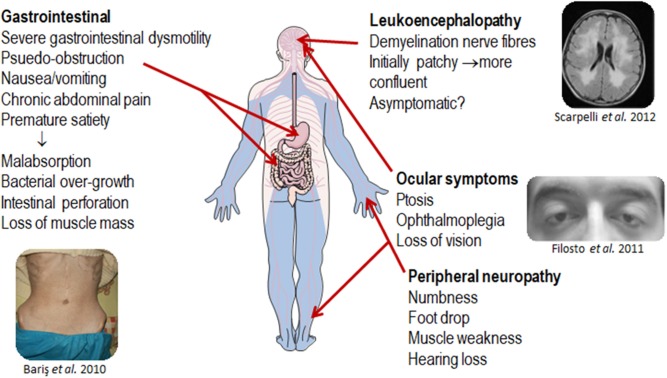
Major clinical features of MNGIE. Copyright permission was obtained for the reproduction of images taken from Bariş et al. (2010), Filosto et al. (2011), Scarpelli et al. (2012).